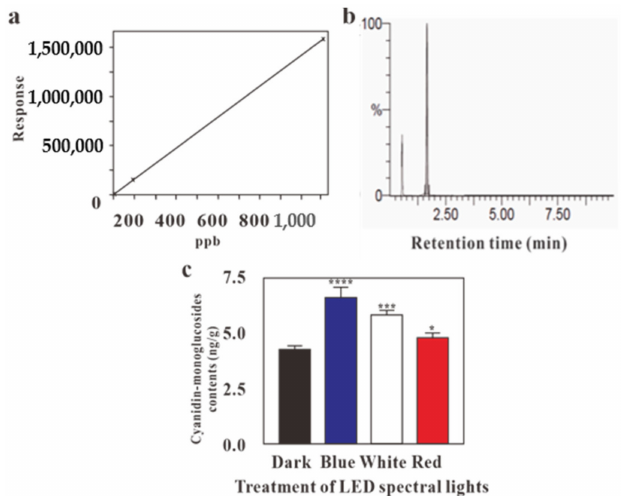
Figure 4. LC-MS profile for the e ff ect of LED lights for cyanidin-monoglucoside content in G. procumbens calli. ( a ) Calibration curve of cyanidin-monoglucoside, ( b ) peak of cyanidin-monoglucosides, ( c ) e ff ect of LEDs on cyanidin-monoglucoside content. Values are means ± standard deviation (SD) from three replicates ( n = 3). Ordinary one-way ANOVA followed by Dunnett’s multiple comparisons test were performed, where p < 0.05, p < 0.001, p < 0.0001, are represented as *, *** and ****,